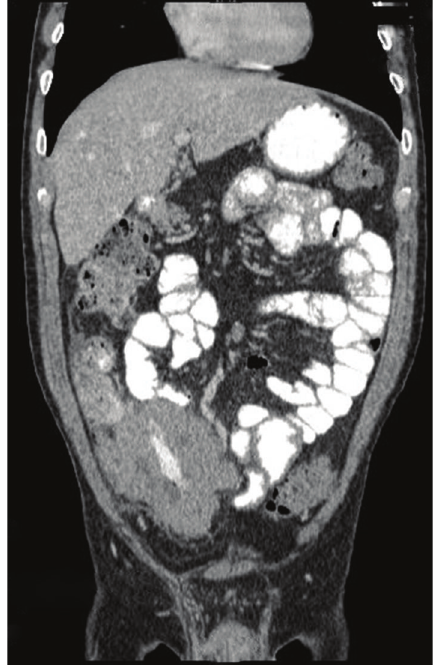
Figure 2: Coronal reformatted multislice abdominal computed tomography displaying a terminal ileum segment in the right-lower quadrant with marked thickening when compared to the adjacent ileal segments and showing mild enhancement after oral and intra- venous contrast agent administration.